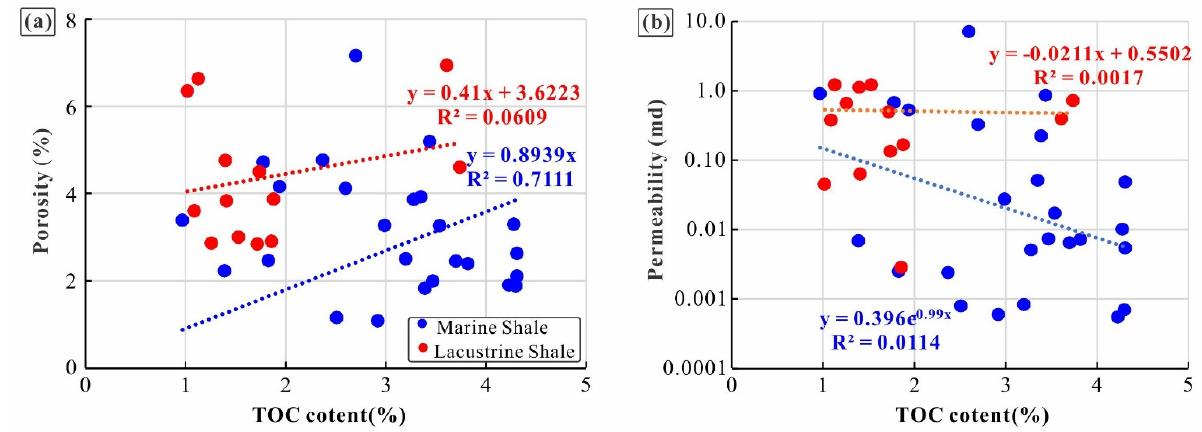
Figure 9. The correlation between TOC and reservoir physical property. ( a ) The correlation between TOC and porosity. ( b ) The correlation between TOC and permeability.